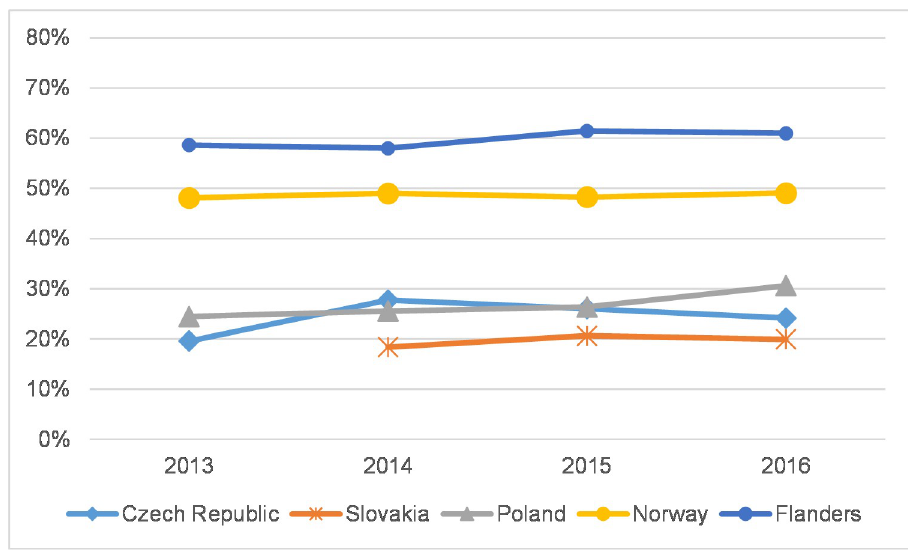
Fig 7. The percentage of articles in Q1+Q2 journals in WoS–social sciences.